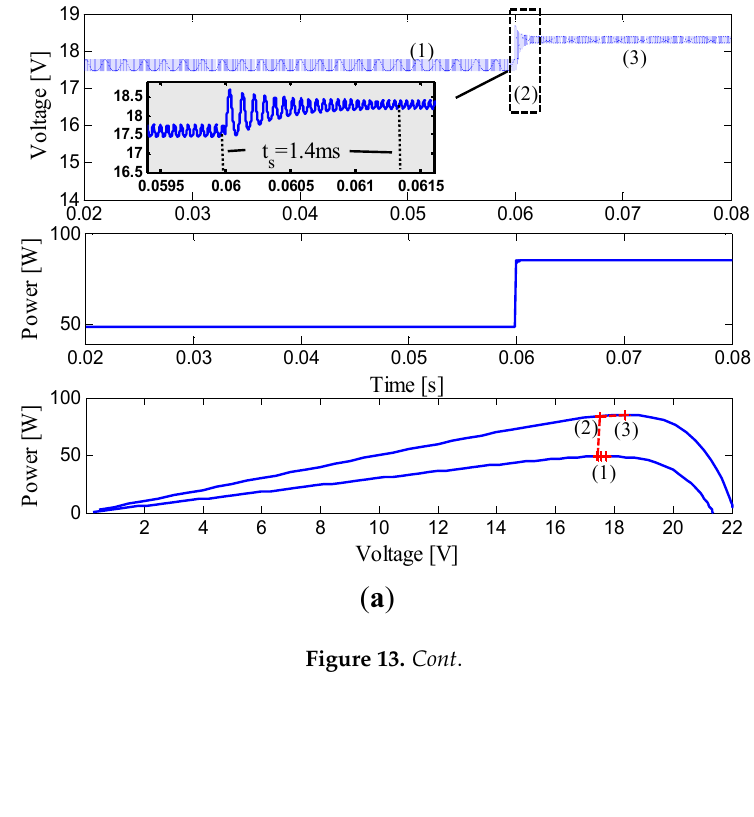
Figure 13. Cont. Figure 13. Cont